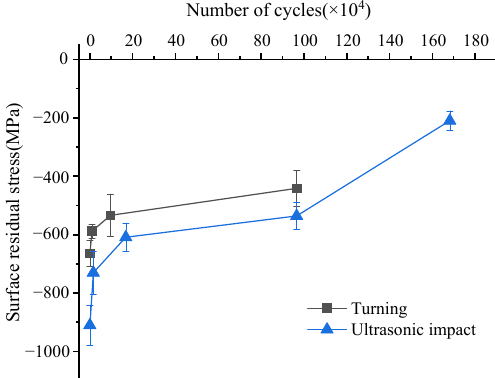
Figure 7. Variation of residual surface stress during fatigue.